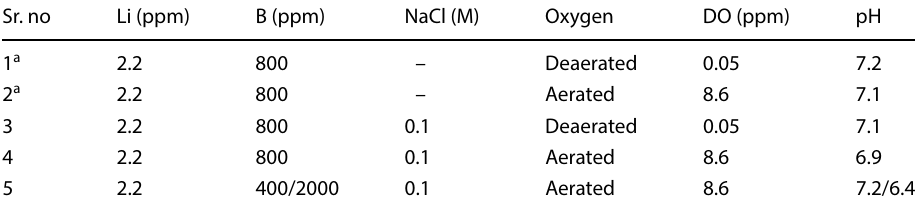
Table 2 The test electrolytes